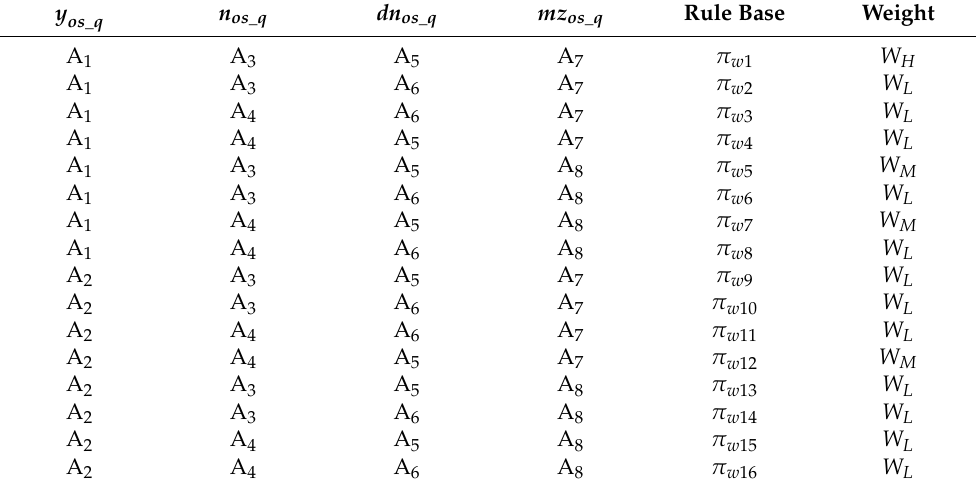
Table 7. The rule base of the